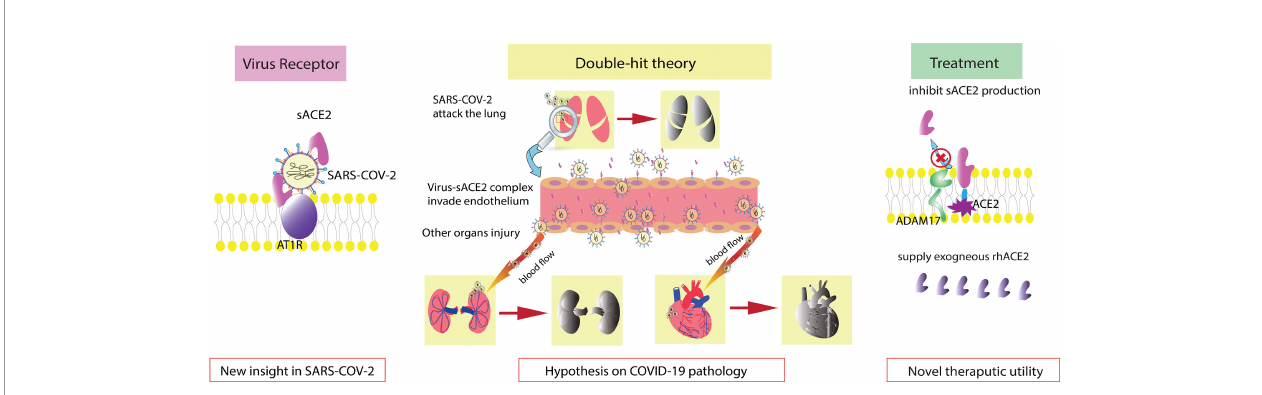
FIGURE 1 | Graphical abstract. sACE2 is also a receptor of SARS-COV-2. Double-hit theory: endothelial injury exacerbates the severity of COVID-19. Regulation of sACE2 production and supplementation with exogenous rhACE2 are new therapeutic